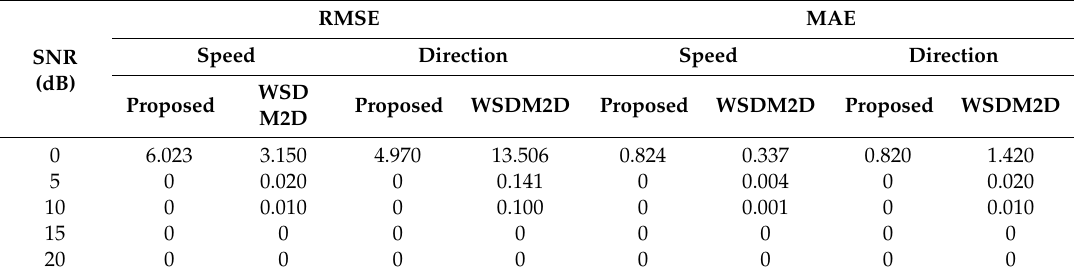
Table 1. Comparison with WSDM2D.